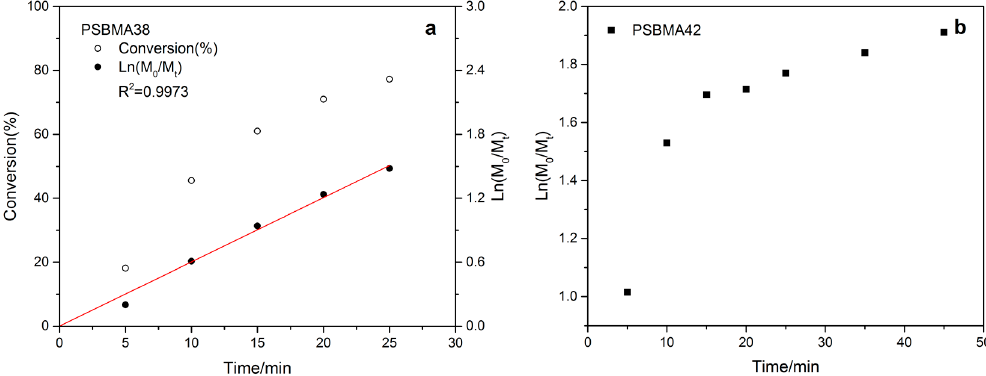
Figure 3. Kinetic plot of Cu 0 -mediated LRP of SBMA for target DP 50—the influence of CuBr to ligand ratio on kinetic and controllability. Table 2. Experimental data of Cu 0 -mediated LRP of SBMA copolymer a